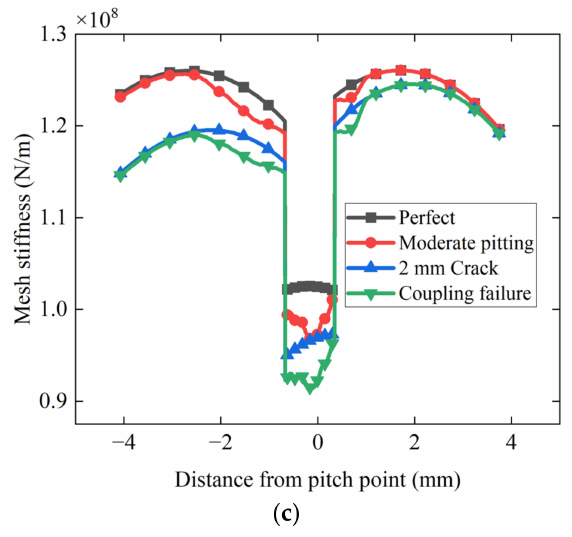
Figure 12. The crack effect on meshing stiffness with moderate pitting: ( a ) At the stage of 1 mm crack;